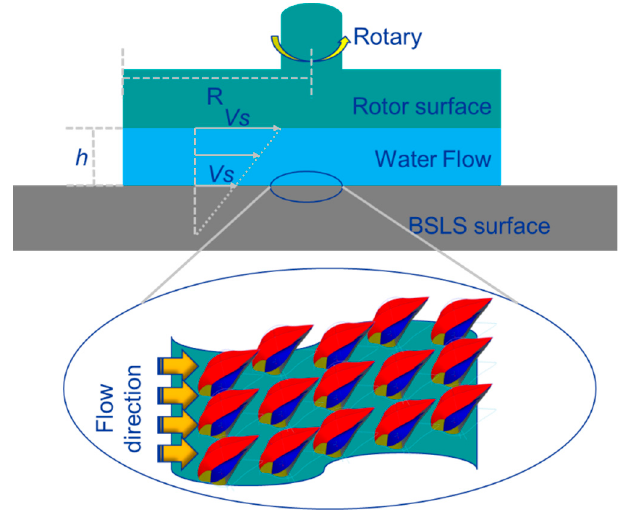
Figure 2. The schematic of the rheometer apparatus for measuring drag reduction, for which dermal denticles were oriented along the water flow.